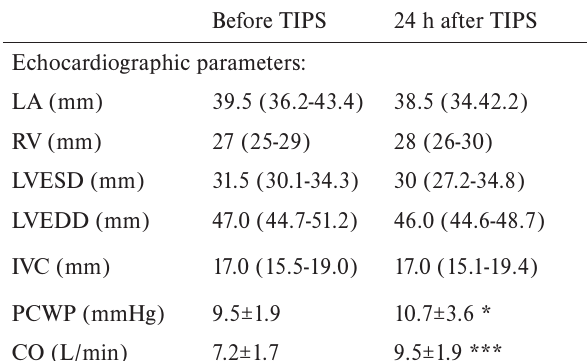
parameters. Before TIPS 24 h after